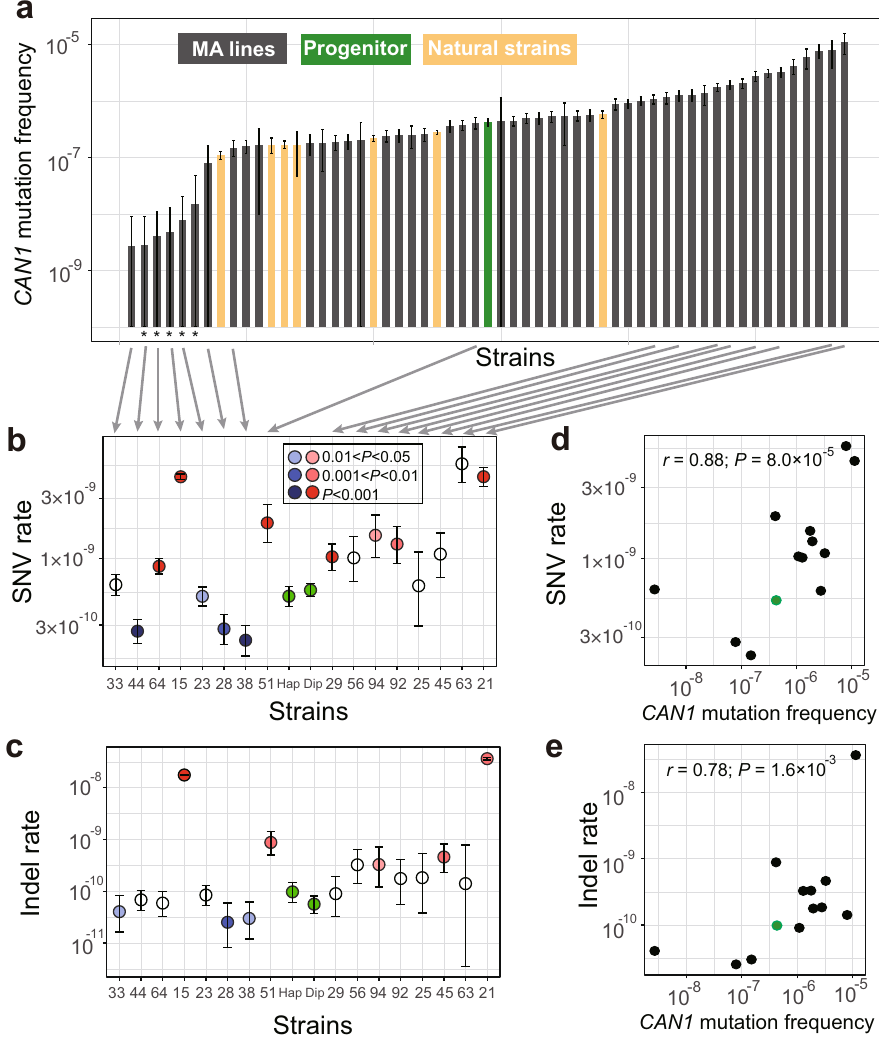
Fig. 2 Mutation frequencies and rates of the MA lines. a CAN1 mutation frequencies of the progenitor (green), 49 MA lines (gray), and 7 natural yeast strains (yellow), determined by the fl uctuation test based on 72 (green and gray) or 288 (yellow) biologically independent cell cultures from each strain. The data from the seven natural strains came from ref. 14 . Error bars indicate 95% con fi dence intervals of the mean. “ ∗ ” on the X-axis indicates diploid or putatively diploid strains. Mutation frequency is the probability of loss-of-function mutation in CAN1 per cell division, so is not directly comparable with the mutation rates estimated by MA + WGS. SNV ( b ) or indel ( c ) mutation rate per site per generation in the progenitor in both haploid and diploid form (green) and 16 MA lines estimated by MA + WGS based on 4 to 20 biologically independent replicates. Numbers on the X -axis refer to IDs of MA lines, while “ Hap ” refers to the progenitor in the haploid form and “ Dip ” refers to the progenitor in the diploid form. Circles represent mean values while error bars show 95% con fi dence intervals predicted from Poisson distributions. Signi fi cant rate differences from the progenitor are indicated by blue (lower than the progenitor) or red (higher than the progenitor) with different shades for different nominal P values from Wilcoxon rank-sum tests. White circles show no signi fi cant rate difference from the progenitor. Correlation between SNV ( d ) or indel ( e ) mutation rate measured by MA + WGS and CAN1 mutation frequency measured in fl uctuation test among the 12 haploid MA lines and the haploid progenitor (green). Pearson ’ s r (based on the values before the log 10 -transformation) and associated P value are shown. The green dot shows the